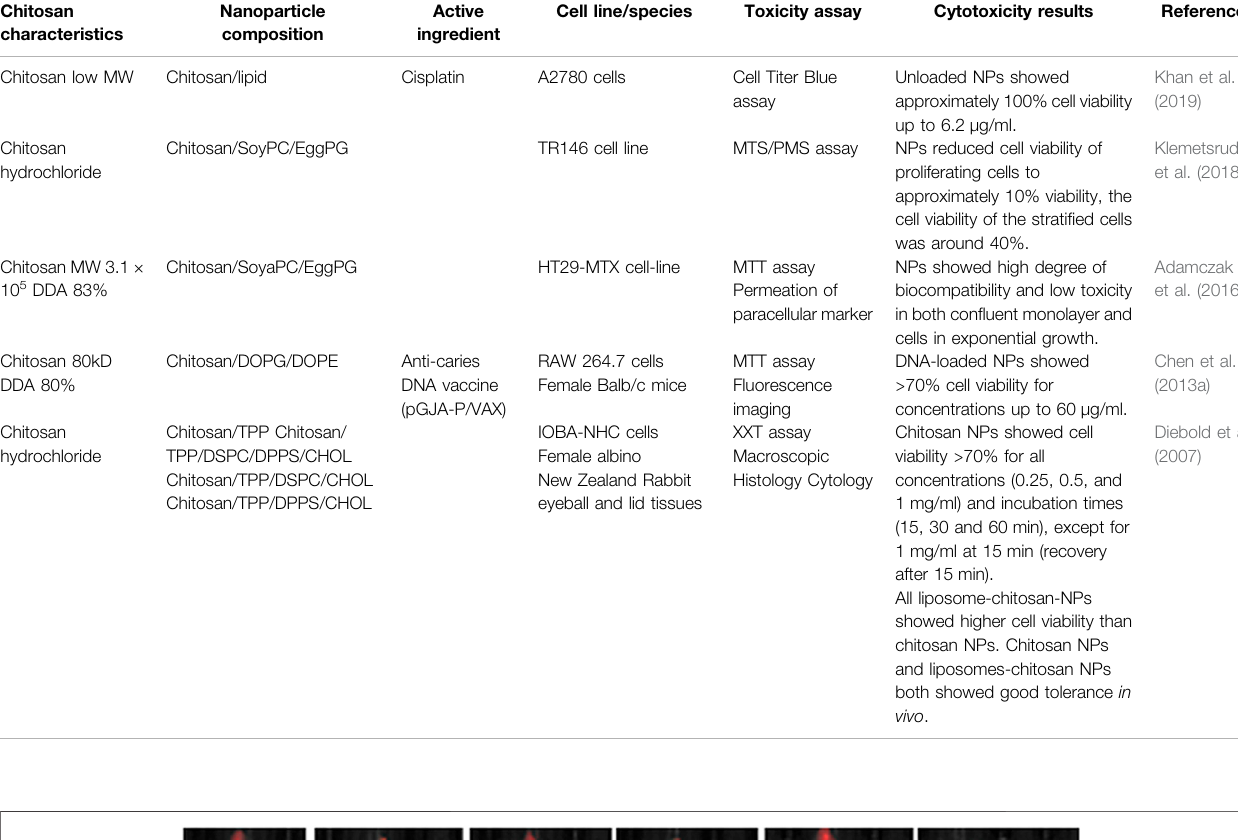
TABLE 3 | Articles on chitosan nanoparticles in combination with liposomes, main fi ndings. Chitosan characteristics